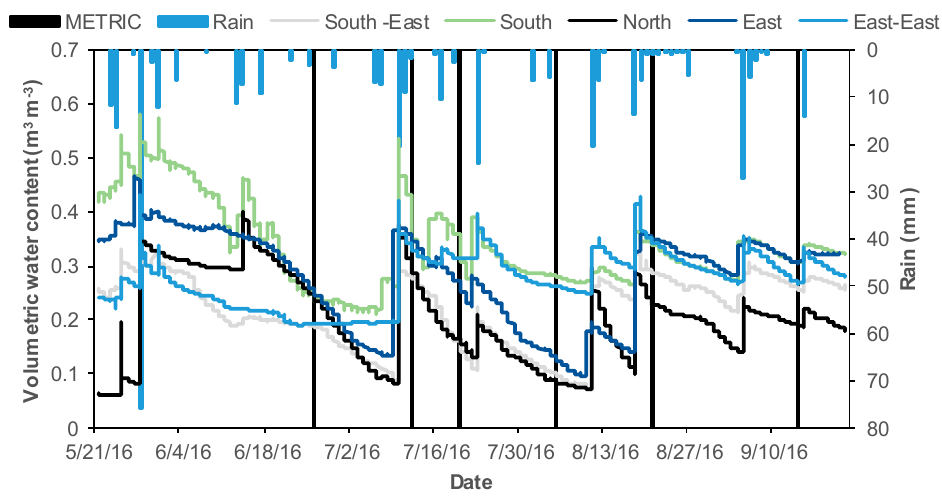
Figure 3. Seasonal trends of soil water content (average depths) at the five observation locations. The blue bars indicate precipitation throughout the corn growing season and the black bars denote remote sensing overpass dates (METRIC).